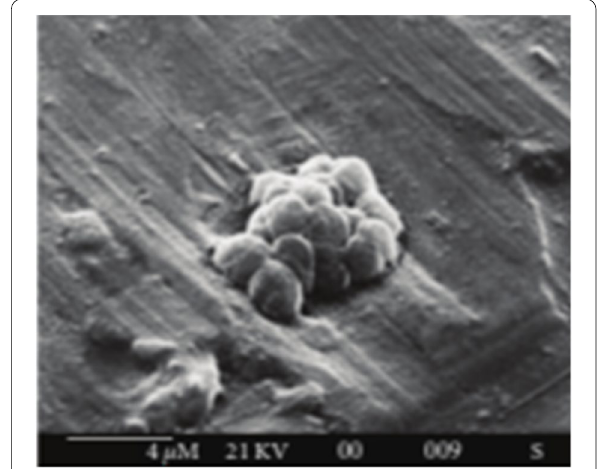
Fig. 1 Biofilm production by H. japonica T5 [31]